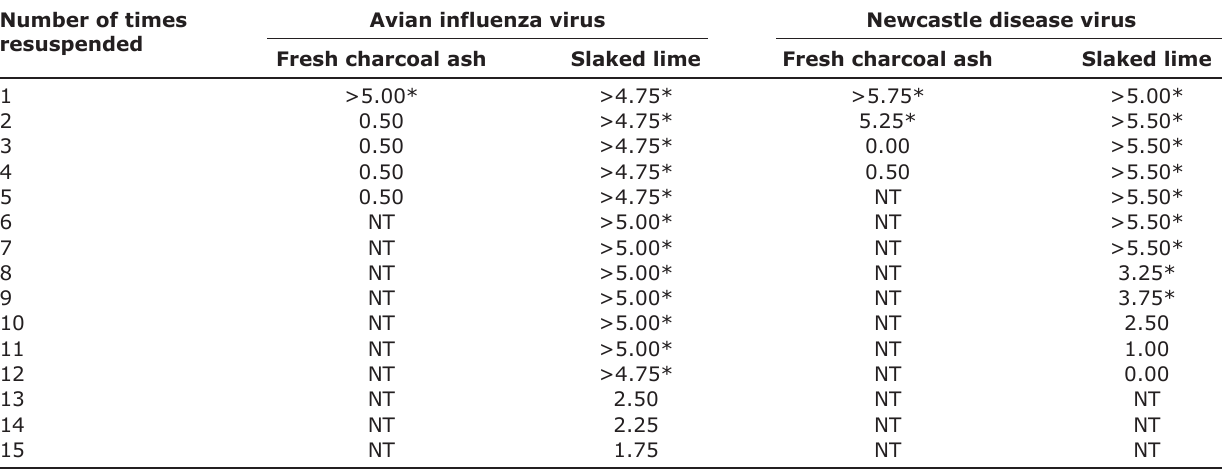
Table-4: The RF (log TCID /ml) of fresh charcoal ash and slaked lime applied for inactivating Newcastle disease virus 10 50 and Avian influenza virus under wet and dry conditions at consecutive re-suspension times with a 3-min incubation period.